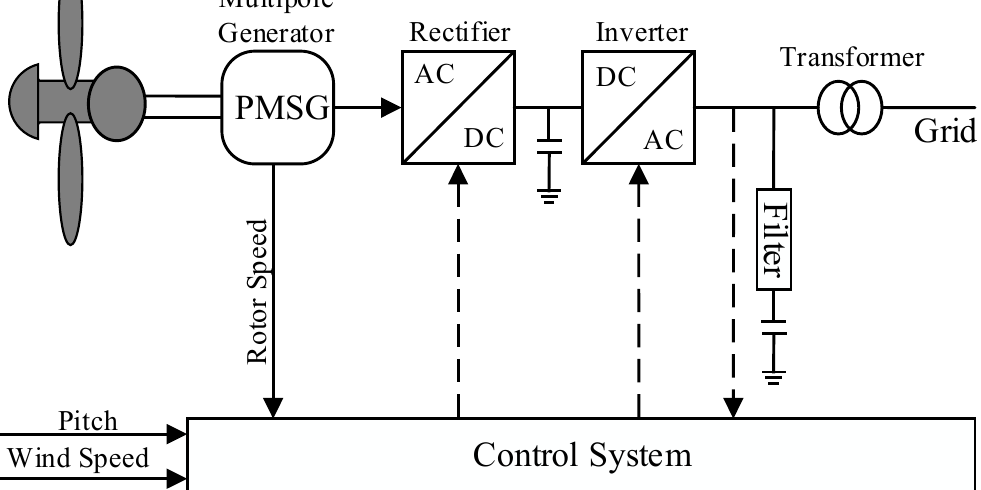
Figure 1. The general PMSG wind turbine system with its control schemes.